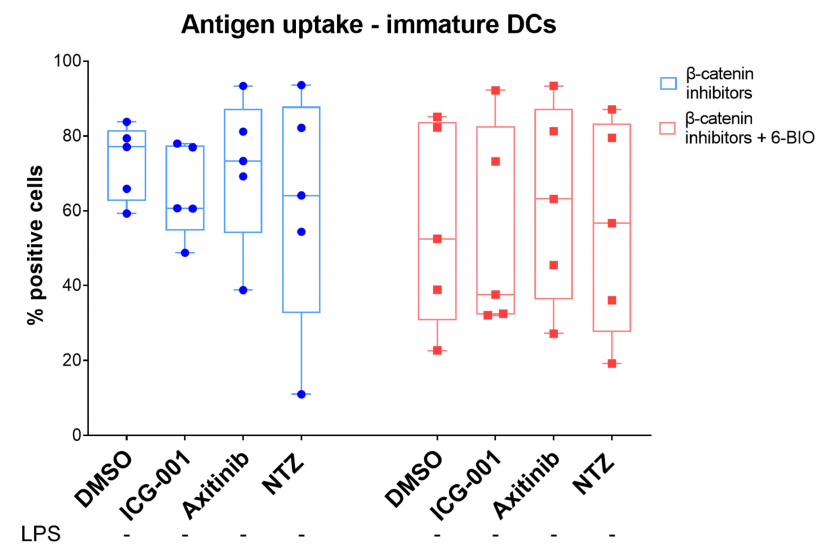
Figure 4. Antigen uptake assay. Immature moDCs obtained from healthy donors were treated with β -catenin inhibitors (4 µ M ICG-001, 10 µ M axitinib, 10 µ M nitazoxanide (NTZ)) with or without 0.5 µ M 6-BIO or DMSO (vehicle) for 24 h. Cells were left untreated with LPS as immature DCs. A total of 50,000 cells were incubated with FITC-dextran at 37 ◦ C. After 1 h of incubation, cells were washed and analyzed immediately by flow cytometry. Each symbol represents a different donor, and lines represent the median.